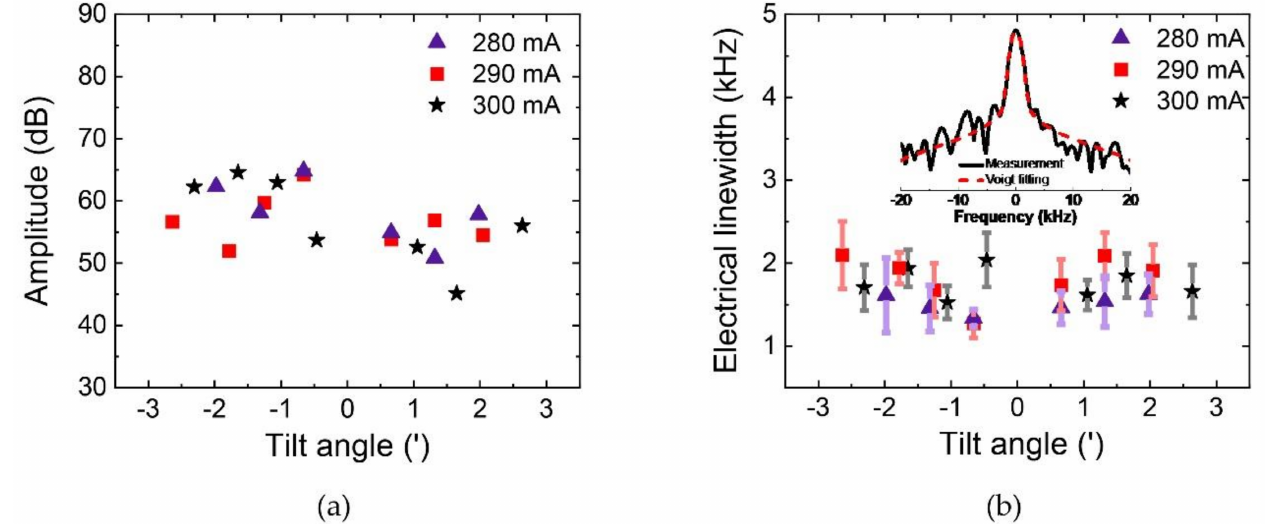
Figure 3. ( a ) Amplitude and ( b ) linewidth of the fundamental electrical signal for pump currents of 280, 290, and 300 mA. Inset is an example of the electrical linewidth fitting using the Voigt